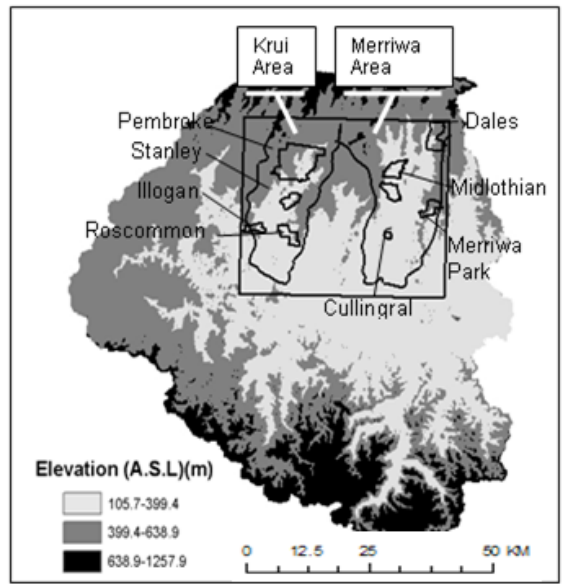
Figure 1. Overview of NAFE’05 focus farms within the Krui and Merriwa